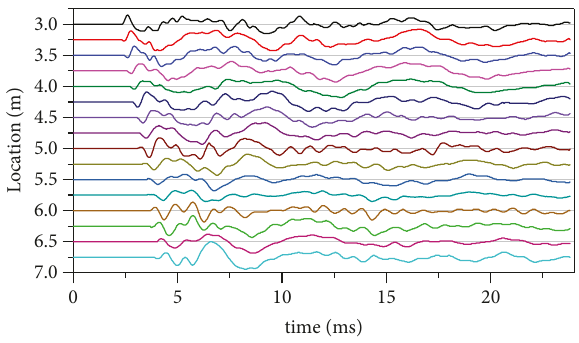
0.2 m and z 4.0m. (cid:29) (cid:29)